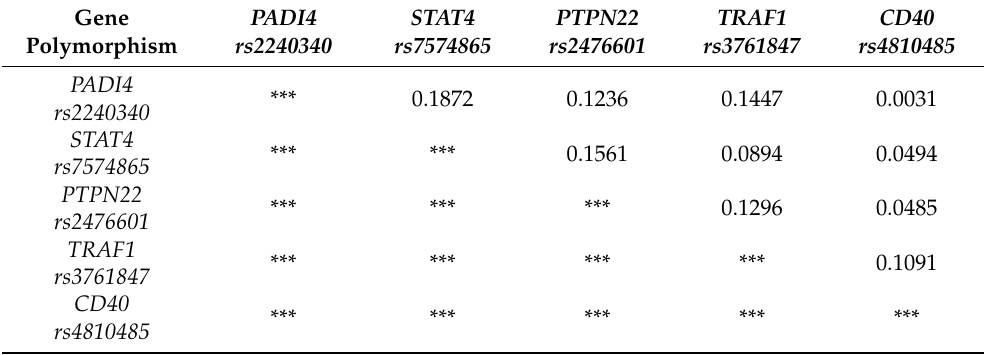
Table 5. Linkage disequilibrium analysis of the 5 selected SNPs in PTPN22 , PADI4 , TRAF1 , STAT4, and CD40 genes. D’ statistic is presented. *** are placed instead of repeated genes or